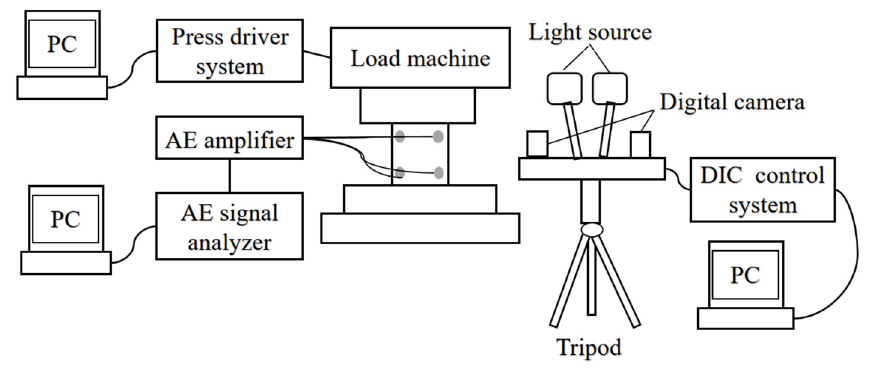
Figure 1. Compression test device.